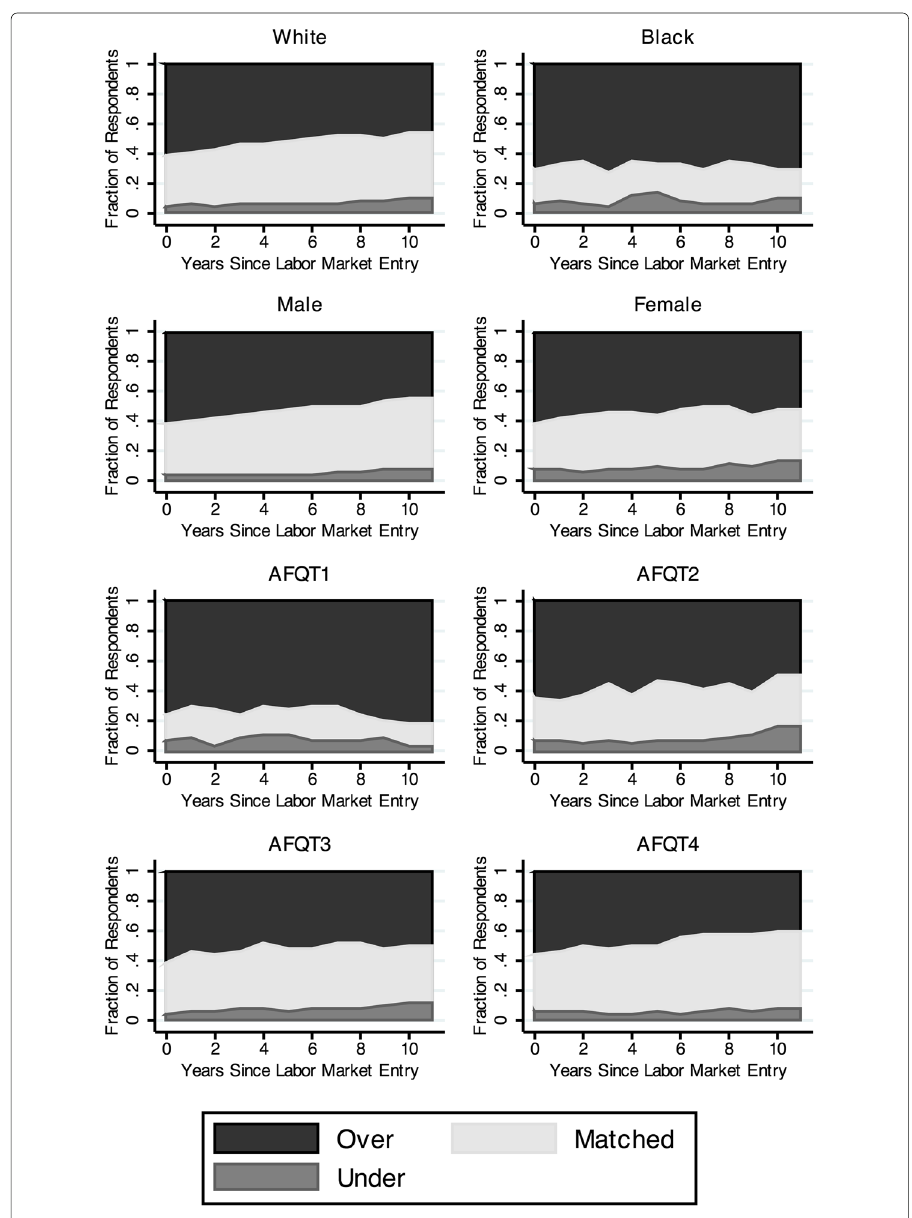
Fig. 3 Composition of overeducation (14 years of education or